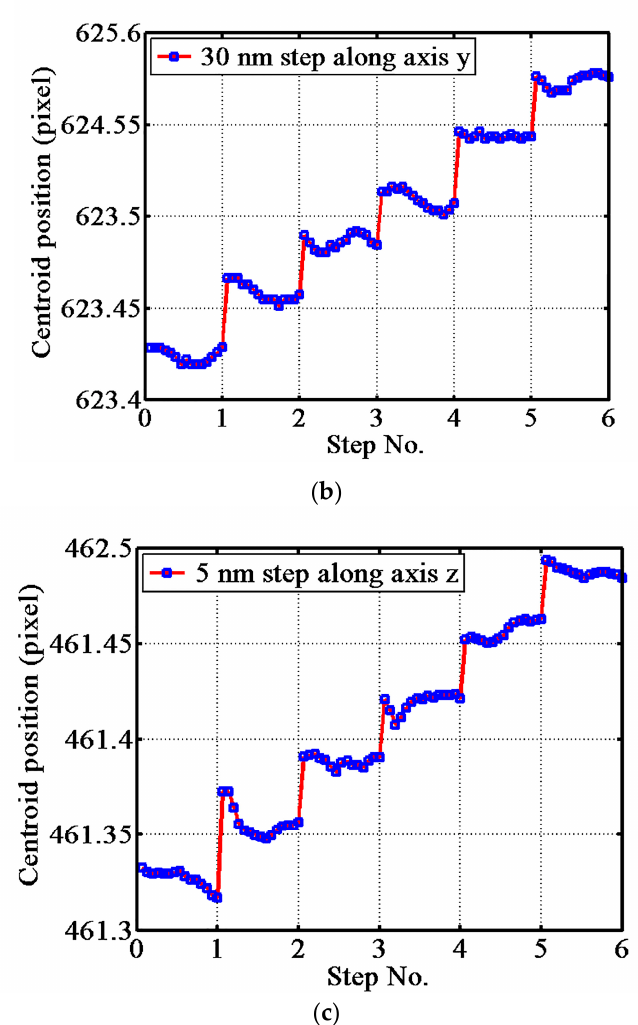
Figure 11. Resolution of the ACF probe: ( a ) along the x-axis, ( b ) along the y-axis; and ( c ) along the z-axis.